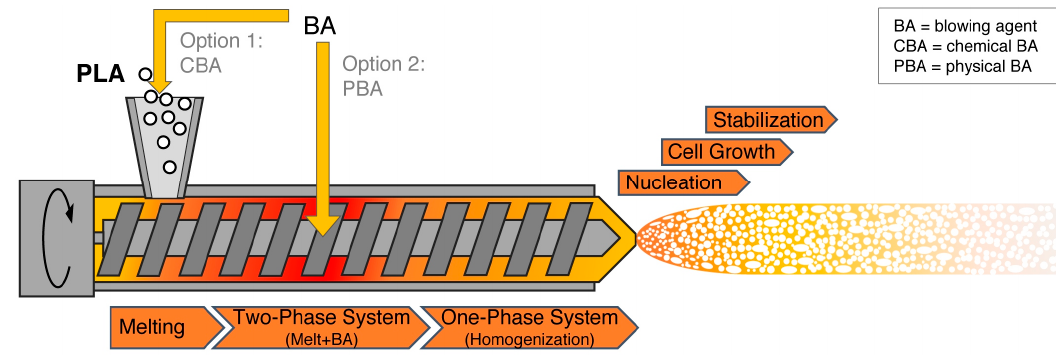
Figure 4. Principle of foam extrusion.